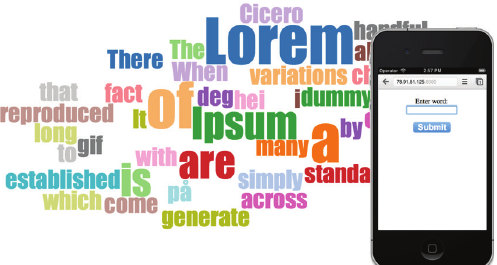
Figure 2: The WordCloud application (student view shown to the right).